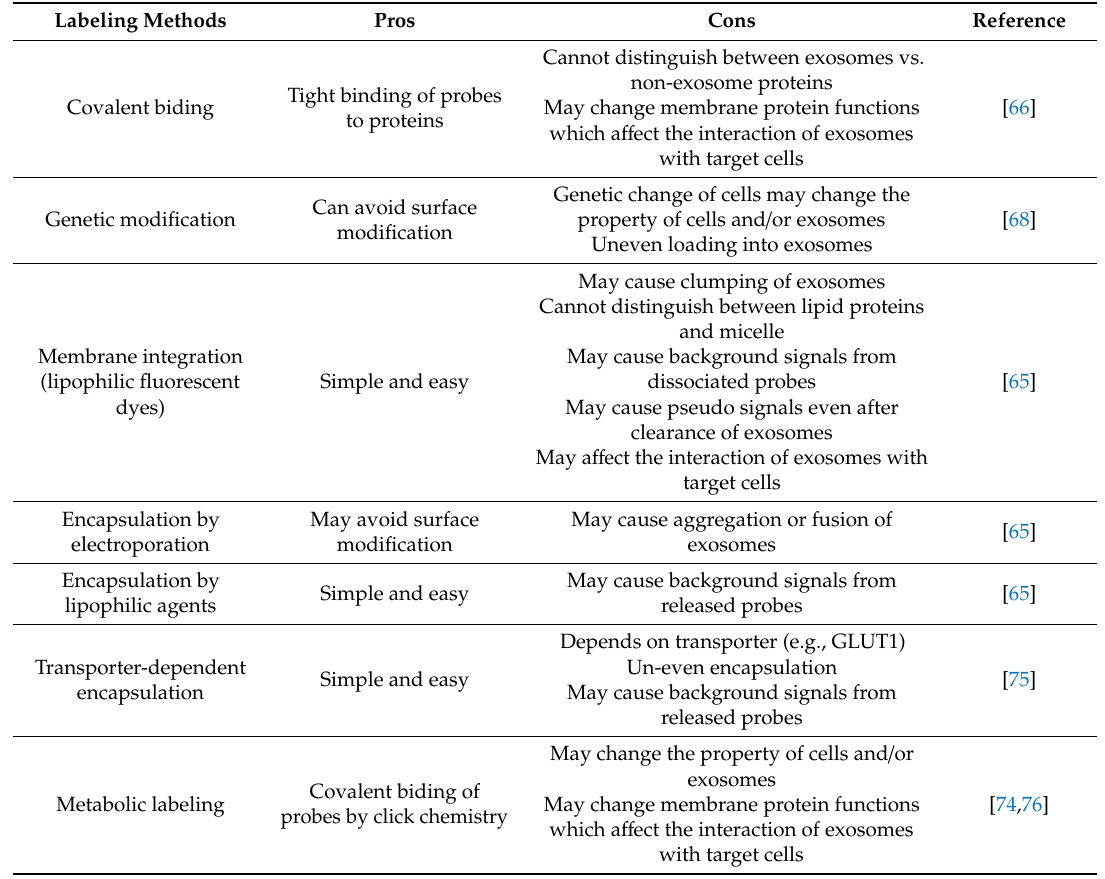
Table 3. Comparison of labeling